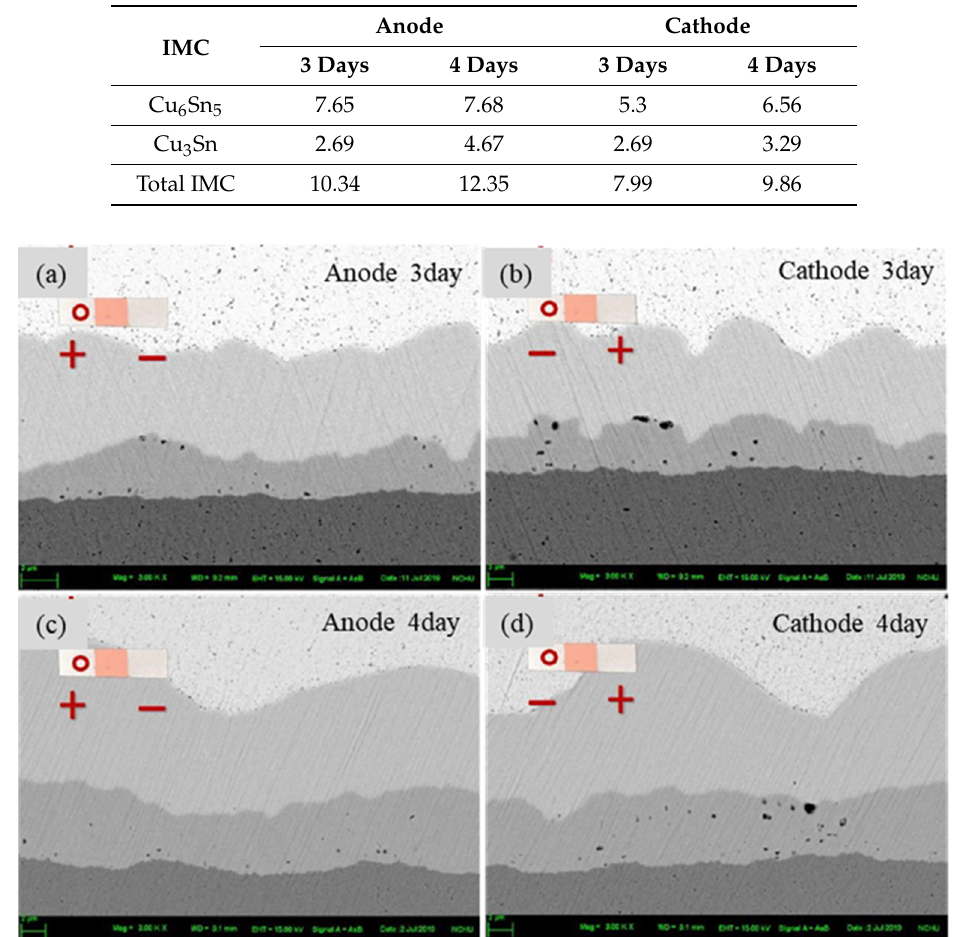
Figure 10. SEM images of 5:5 sample heated at 180 °C and subjected to a current of 0.8 A. ( a ) Anode side (indicated on red circle) for 3 days; ( b ) Cathode side for 3 days; ( c ) Anode side for 4 days; ( d ) Cathode side for 4